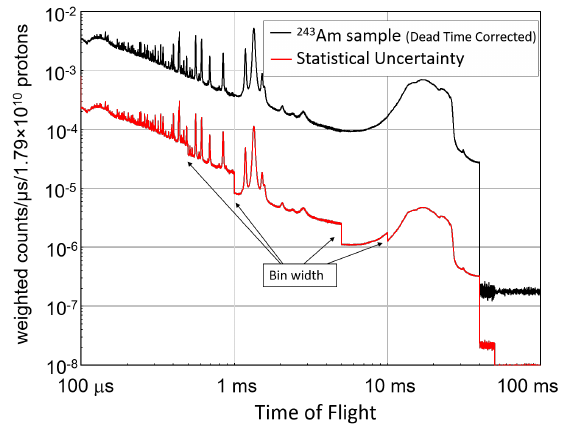
Figure 5. Weighted TOF spectrum of 243 Am sample with the dead time correction and the deduced uncertainty.